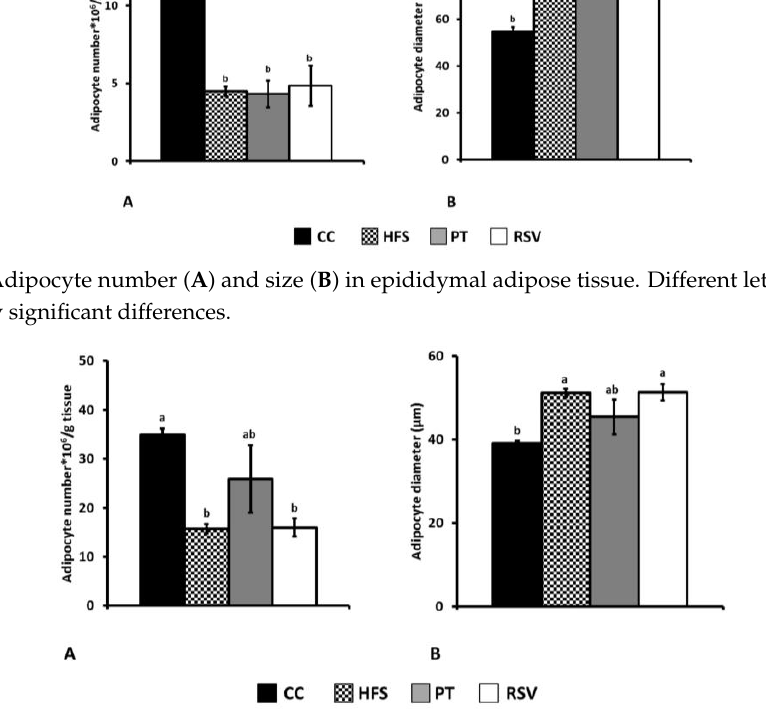
Figure 4. Adipocyte number ( A ) and size ( B ) in subcutaneous adipose tissue. Different letters indicate statistically significant differences.